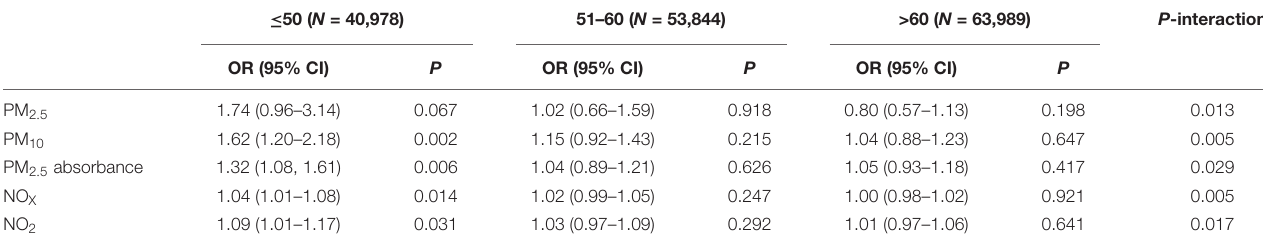
TABLE 4 | Associations of air pollution and hearing impairment in subgroups stratified by age. ≤ 50 ( N = 40,978)